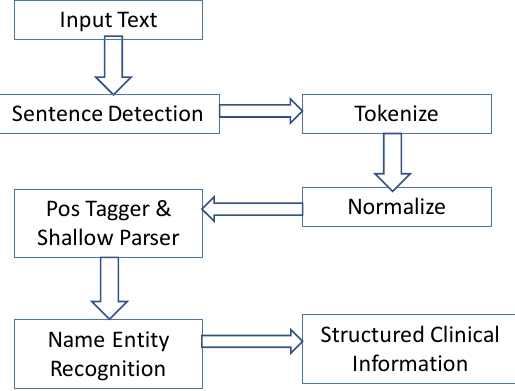
Figure 7. Schema of developed components involved in the text processing.